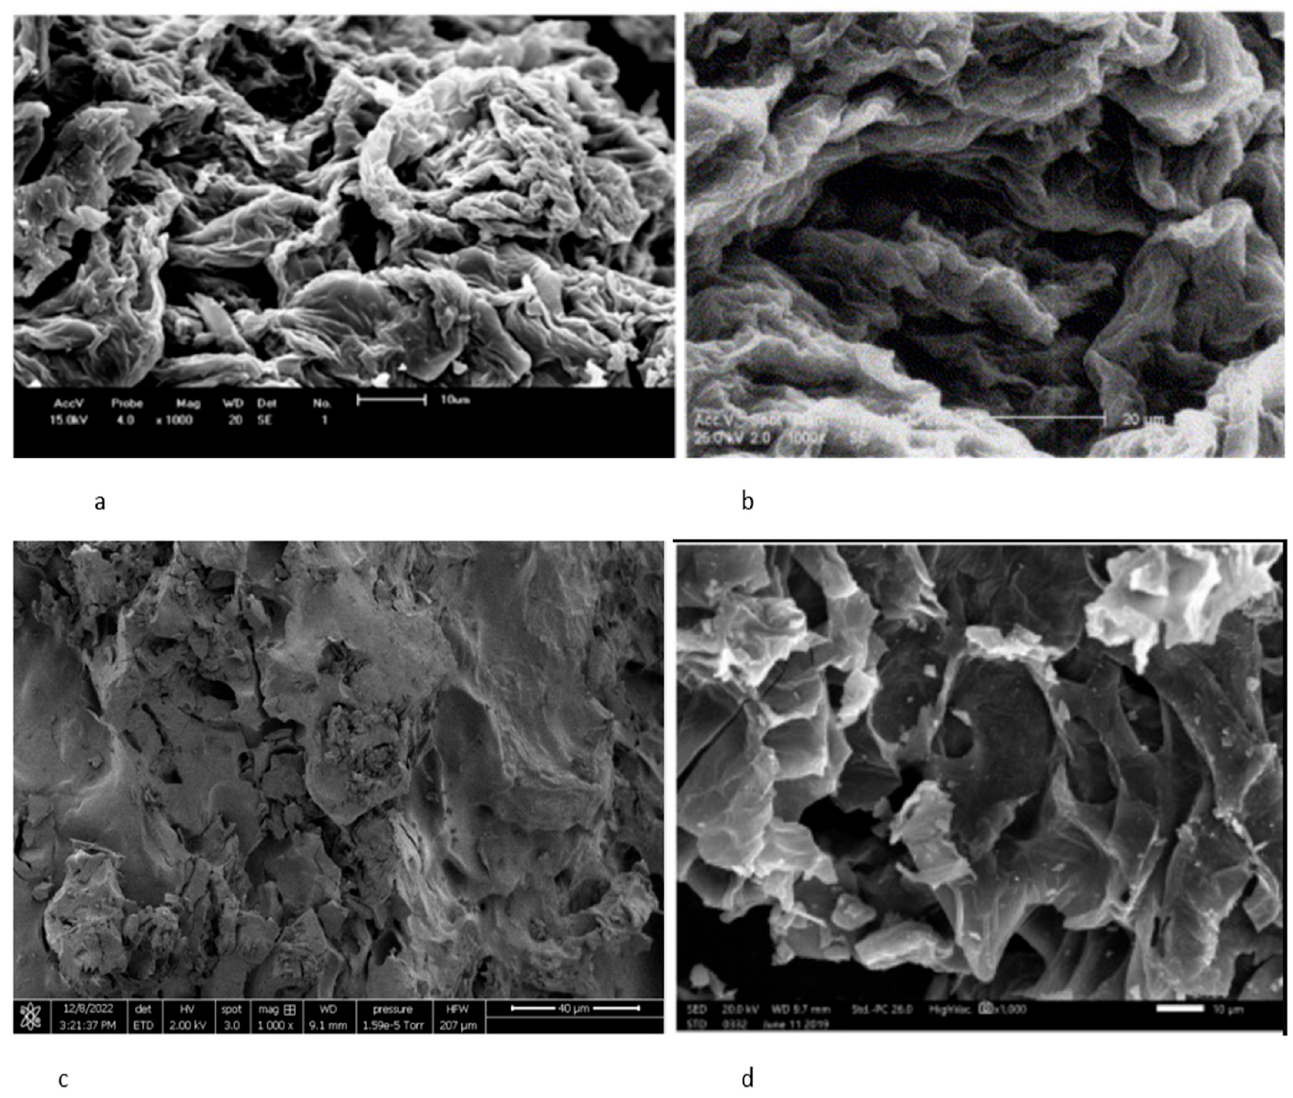
Figure 5. ( a ) SEM images of physically modified orange peel, ( b ) physically modified OP after adsorption [74], ( c ) thermally modified orange peel at 300 °C (this study), ( d ) thermally modified orange peel at 300 °C [13].